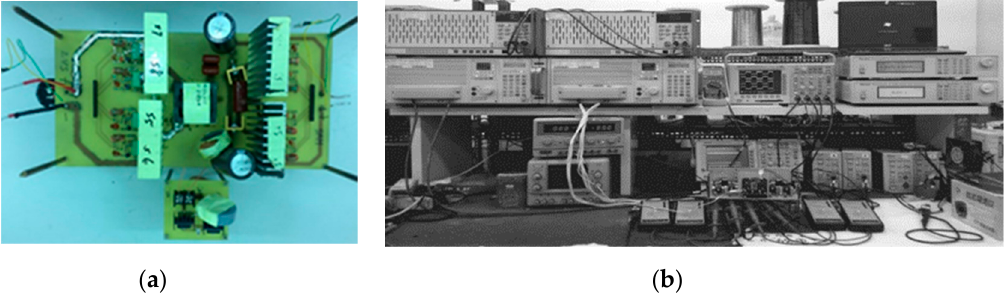
Figure 15. Pictures of the presented circuit: ( a ) prototype circuit; ( b ) experimental setup.